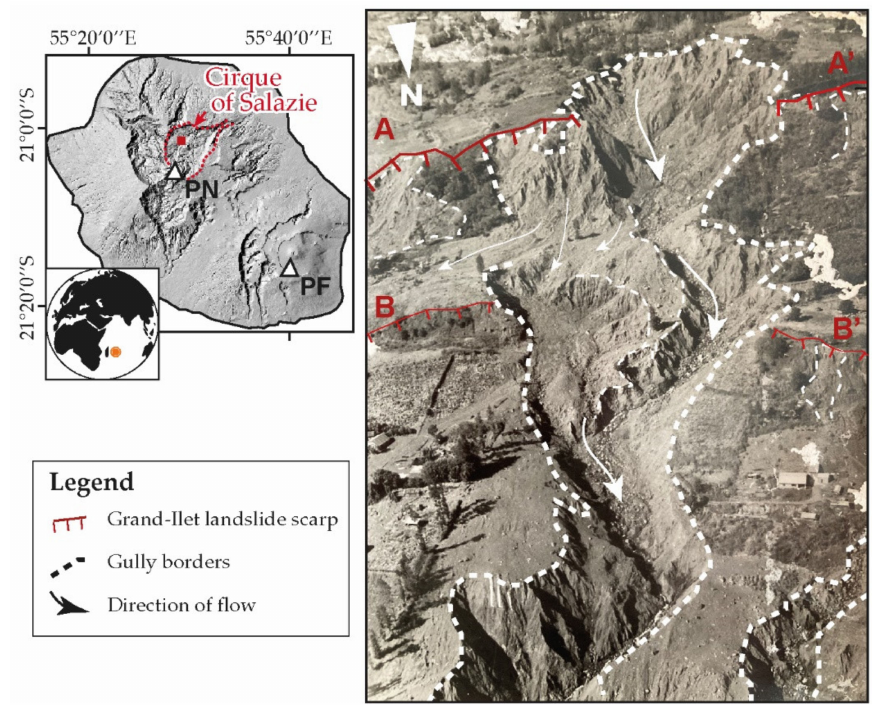
Figure 1. Photograph, modified from Pinchinot (1984) [8], of the d é boul é of the Ravine de l’Eglise taken just after Cyclone Hyacinthe. The photo was taken in the field, at a date that is not exactly known. Grand Ilet is located by the red square in the image of Reunion Island to the left. PN, Piton des Neiges; PF, Piton de la Fournaise. Houses on the left side of the picture give the scale. AA’ and BB’ are scarps of Grand-Ilet